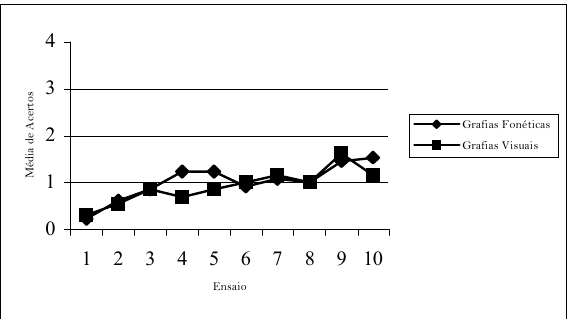
Figura 2. Indivíduos sem conhecimento do nome das letras: número médio de repostas corretas por ensaio em função do tipo de grafia.